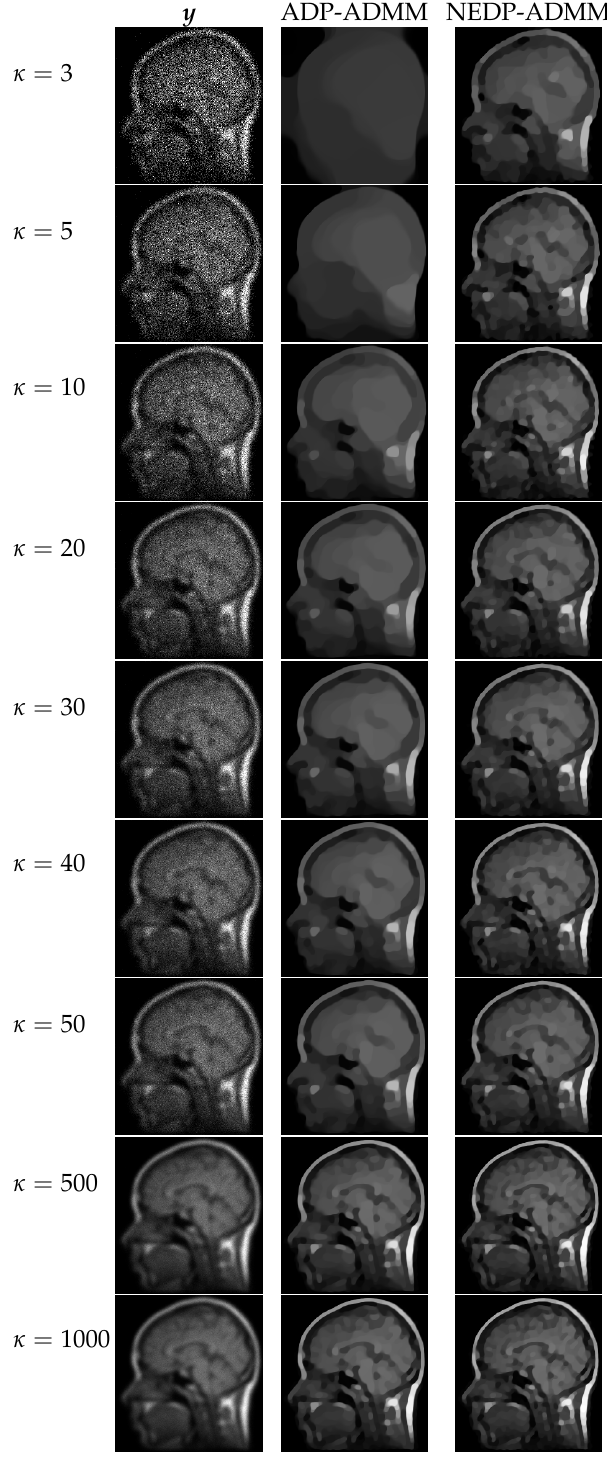
Figure 11. Test image brain . Left column: observed data y corrupted by Gaussian blur with parameters band = 13, sigma = 3 and Poisson noise with different κ -values ranging from 3 to 1000. Middle column: restorations by ADP-ADMM. Right column: restorations by